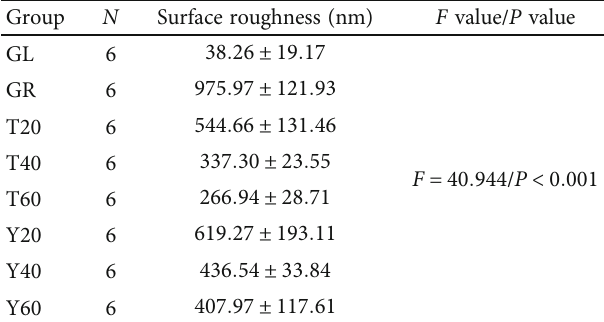
Table 2: Roughness comparison between groups.